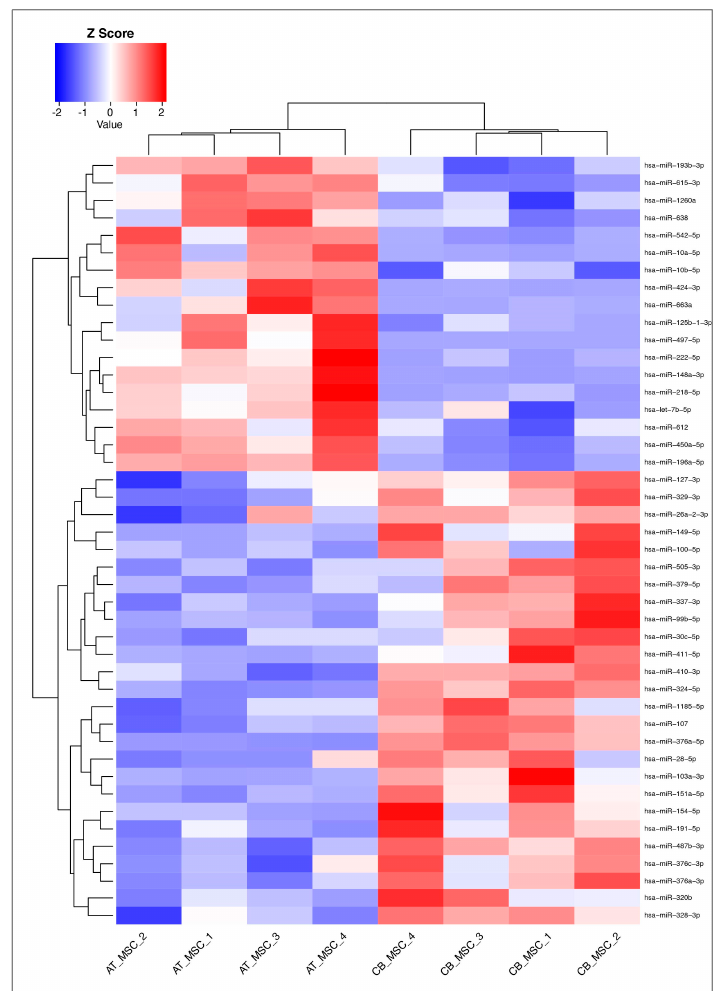
Figure 6. Venn diagram of miRNAs found in CB- and AT-MSC-derived EVs. In total, 752 miRNAs were analyzed and categorized according to mean CTcorr values. High miRNA expression means CTcorr value ≤ 29.99; low miRNA expression means CTcorr value = 30.00–32.99. Five hundred and forty-seven miRNAs were not detected in EVs from CB-MSCs or in EVs from AT-MSCs (mean CTcorr value ≥ 33.00). Biomolecules 2020 , 10 x